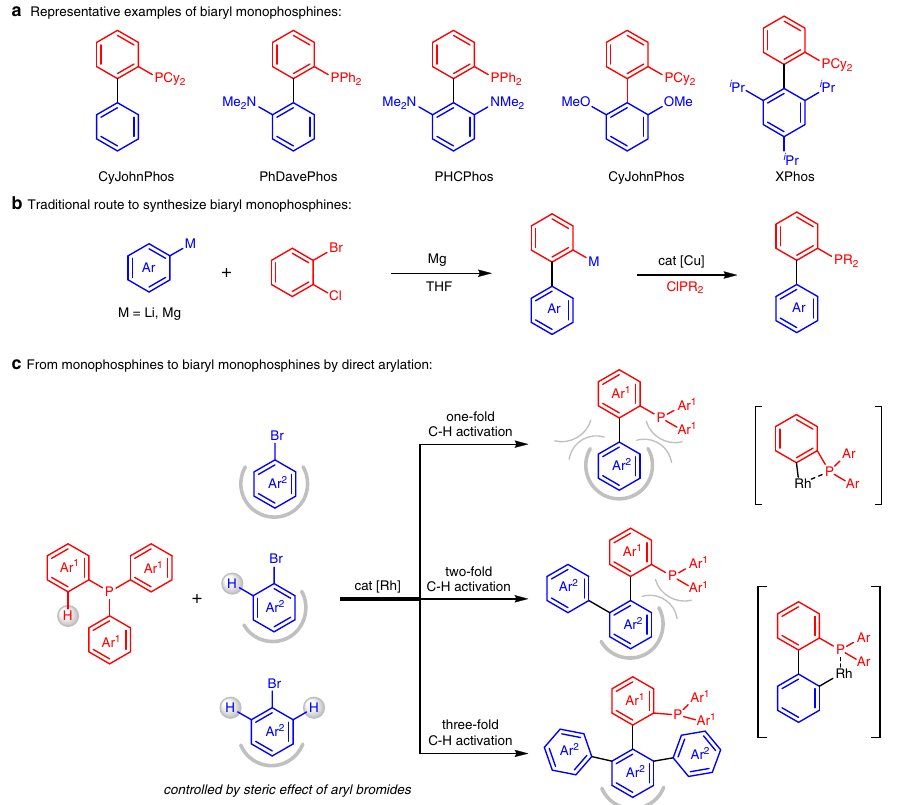
Fig. 1 Construction of biaryl monophosphine ligands. a Some commercially available biaryl monophosphines. b Palladium-catalyzed carbon-phosphorus bond metathesis. c Rhodium-catalyzed tunable direct arylation of phosphines with aryl